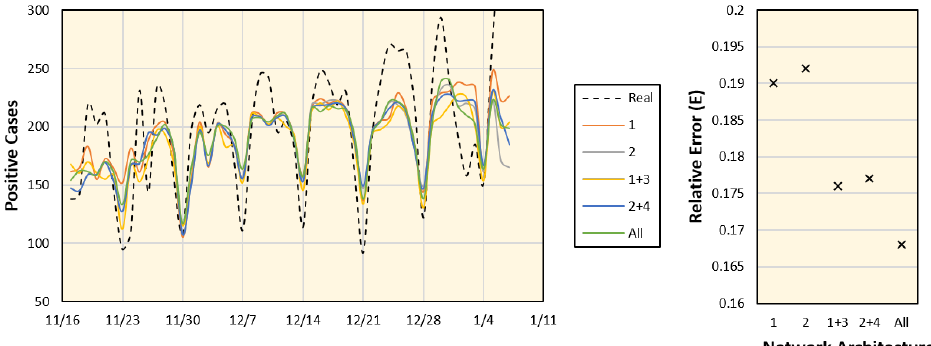
Figure 12. Number of positive cases estimated for Aichi ( left ) and corresponding errors ( right ) using different sub-networks as labeled in Figure